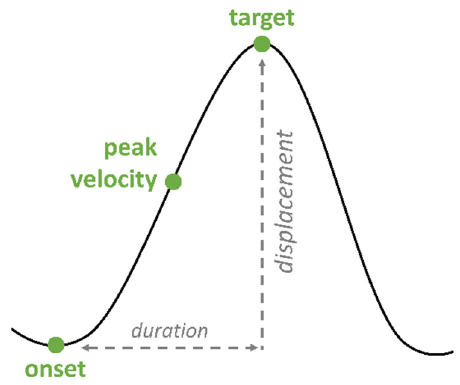
Figure 3. Articulatory landmarks of a schematized gesture.